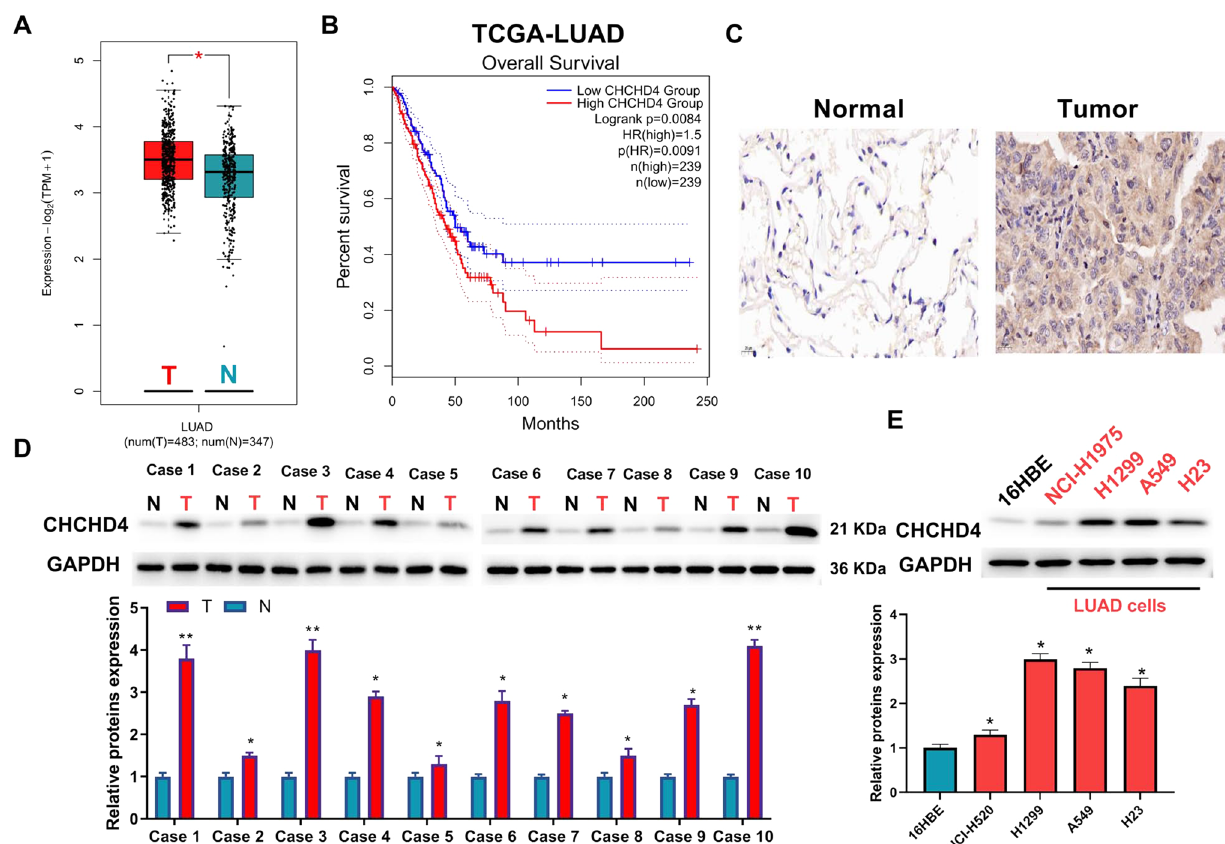
Fig. 1 CHCHD4 overexpression was found in LUAD patients and cells and was closely associated with a poor prognosis. A CHCHD4 differ- ential expression in GEPIA database. B The survival curves of LUAD patients from GEPIA database. C Immunohistochemistry Assessment of CHCHD4 expression in LUAD tissues using immunocytochemistry. Assessment of the protein levels of CHCHD4 in the tissues of patients with LUAD ( D ) and LUAD cells ( E ) using western blot. * P < 0.05, ** P <